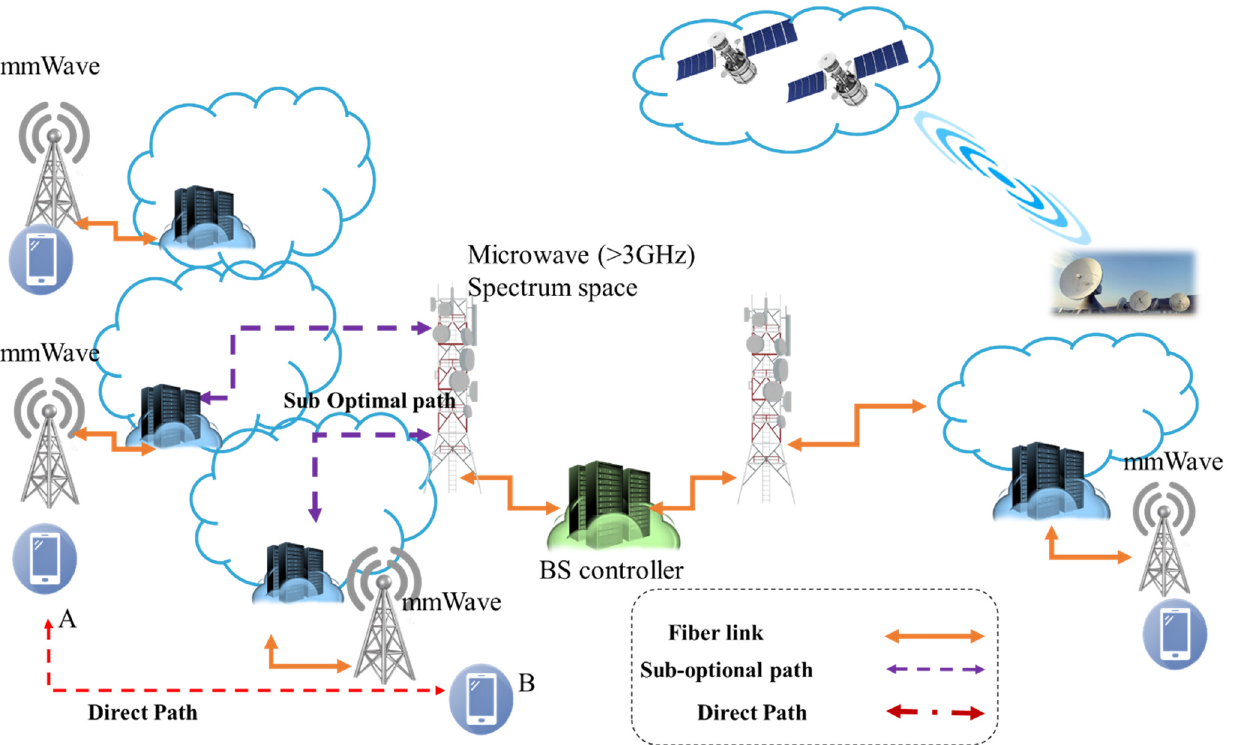
Figure 6. A distributed network that places content servers in the access network.